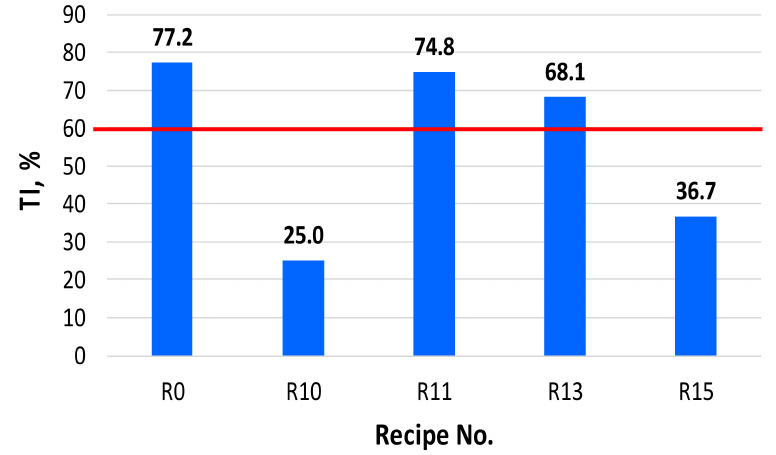
Figure 4. Tumbler index of reference and developed briquettes; the red line represents the minimum accepted level of TTH for the blast